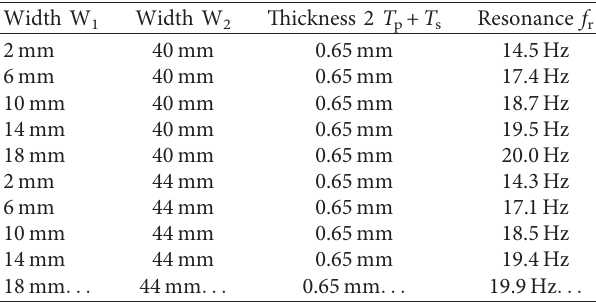
Table 2: Resonance frequency when the widths of the bimorph